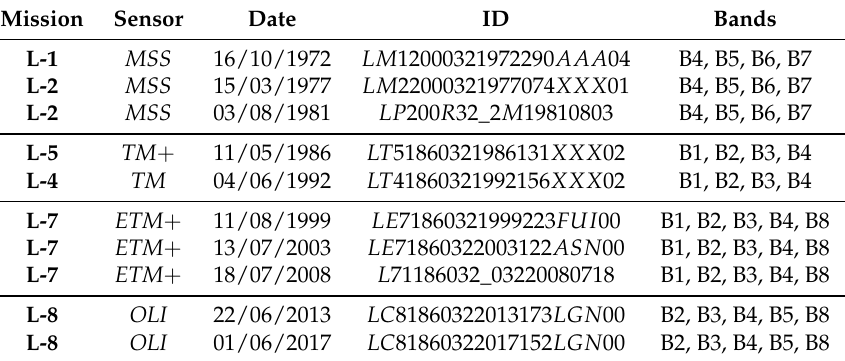
Table 2. LANDSAT data.